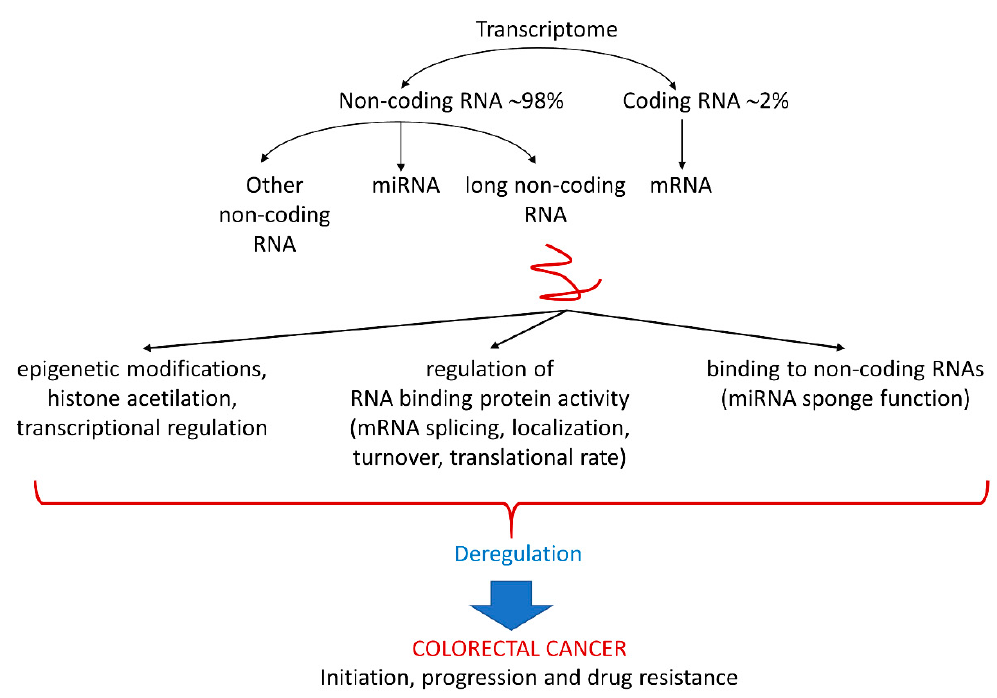
Figure 1. Alteration of lncRNAs molecular mechanisms in CRC initiation, progression, and drug resistance.